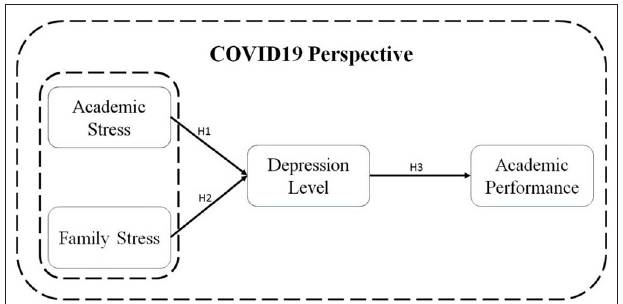
FIGURE 1 | Conceptual